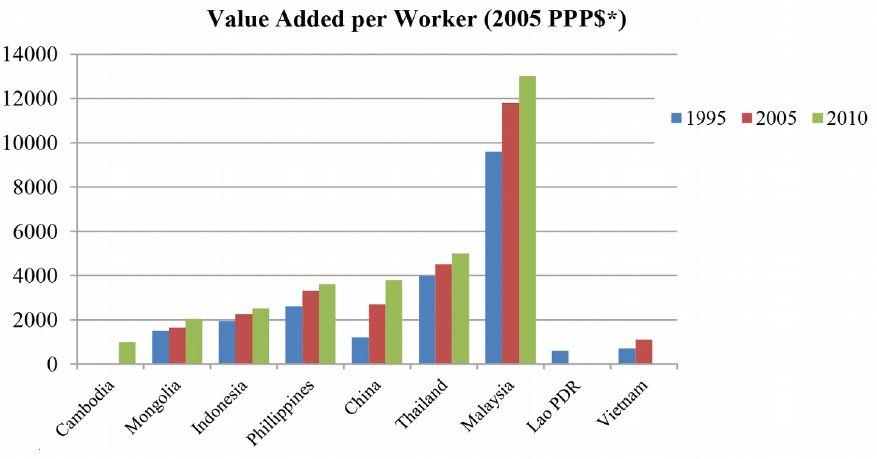
Figure 1. Indonesia Productivity Rate Compared with the Neighborhood Country (World Bank,